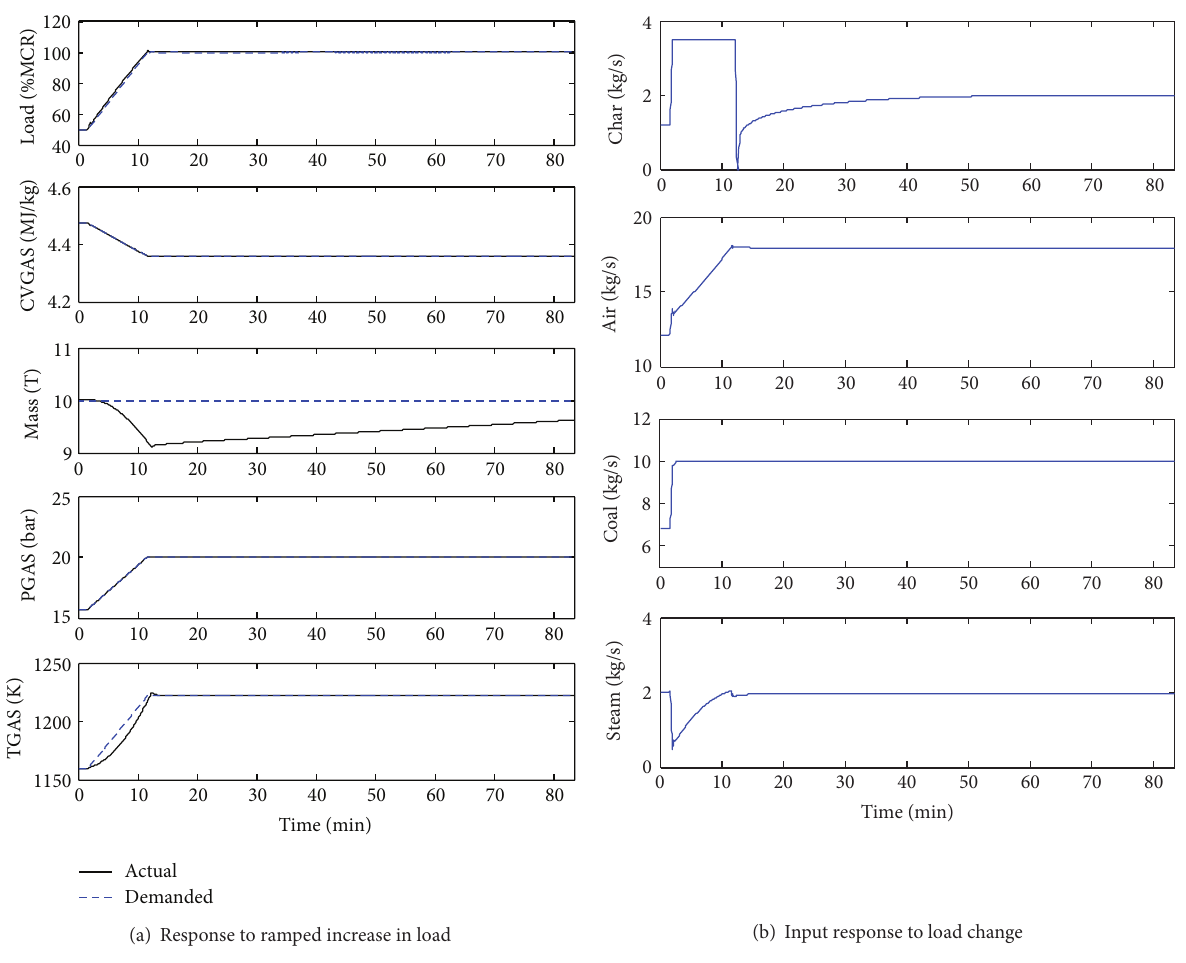
Figure 5: Response to load increase from 50% to 100%